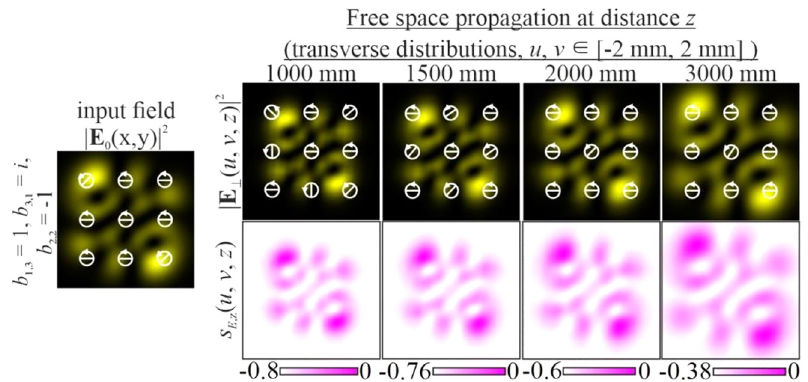
Figure 6: Propagation of a circularly polarized multimode HG beam defined by Eq. (11) with indices satisfying the condition de fi ned by Eq. (12) (a uniformly polarized vector